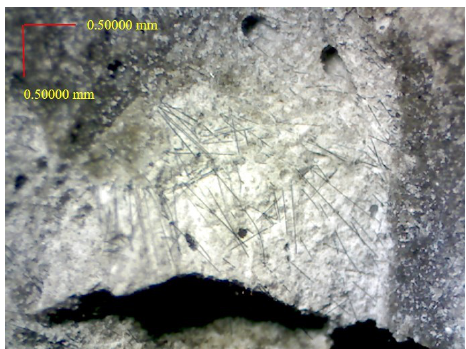
Figure 16. The optical microscopic photo of the specimen using high-temperature heating process after impact test.